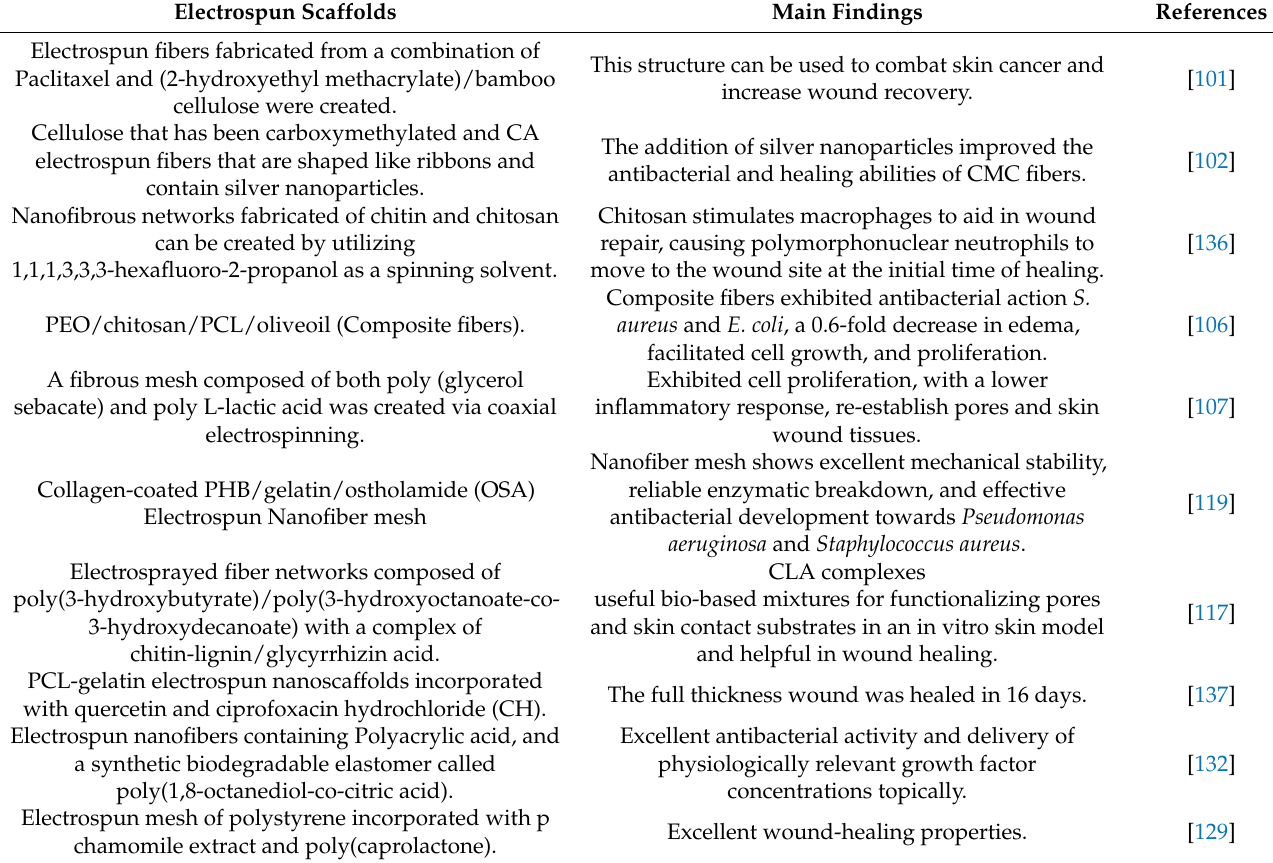
Table 5. Summary of various electrospun scaffolds in wound